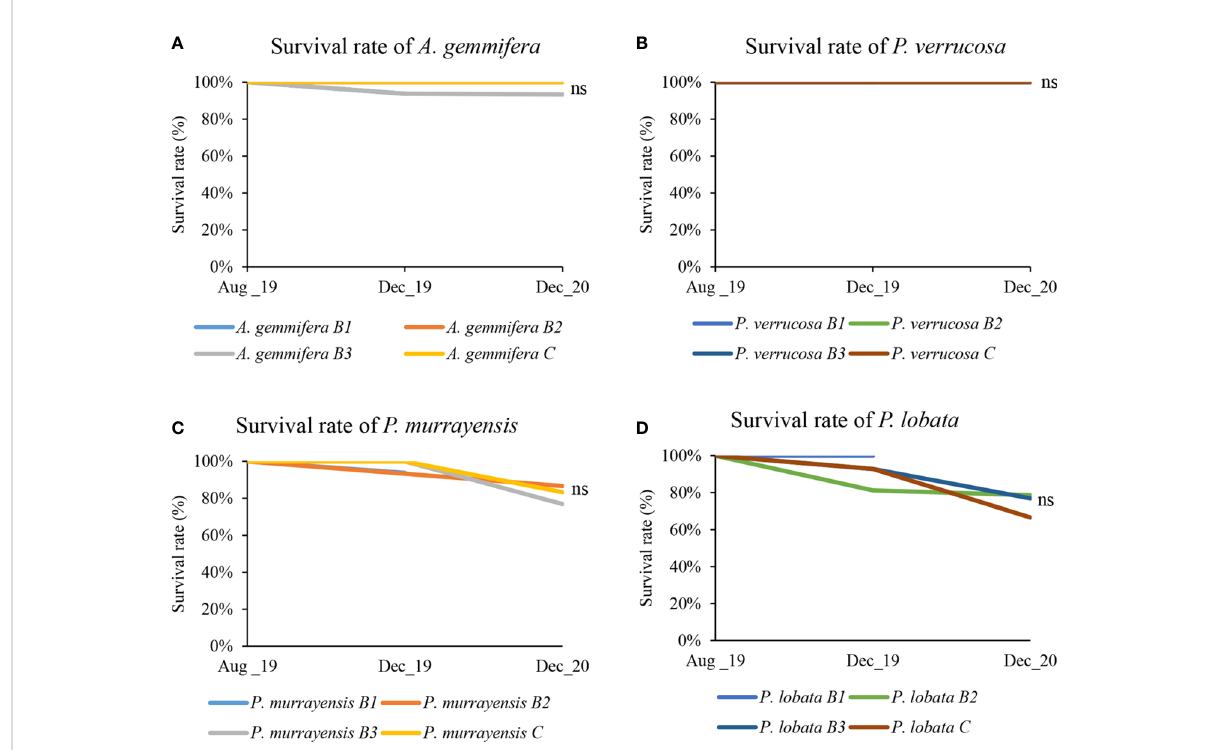
FIGURE 4 Survival rate of both growth forms, excluding lost fragments. (A) survival rate of A. gemmifera ; light blue, orange, gray, and yellow represent the survival rates of A. gemmifera on structure B1, B2, B3, and control respectively. (B) survival rate of P. verrucosa ; medium blue, light green, dark blue, and brown represent the survival rates of P. lobata on structure B1, B2, B3, and control respectively. B1 – B3 as electro-stimulated structures and C as control structure, (ns, not signi fi cant). (C) survival rate of P. murrayensis ; light blue, orange, gray, and yellow represent the survival rates of P. murrayensis on structures B1, B2, B3, and control respectively. (D) survival rate of P. lobata ; medium blue, light green, dark blue, and brown represent the survival rates of P. lobata on structures B1, B2, B3, and control respectively ns: not signi fi cant. ns, not signi fi cant, p <